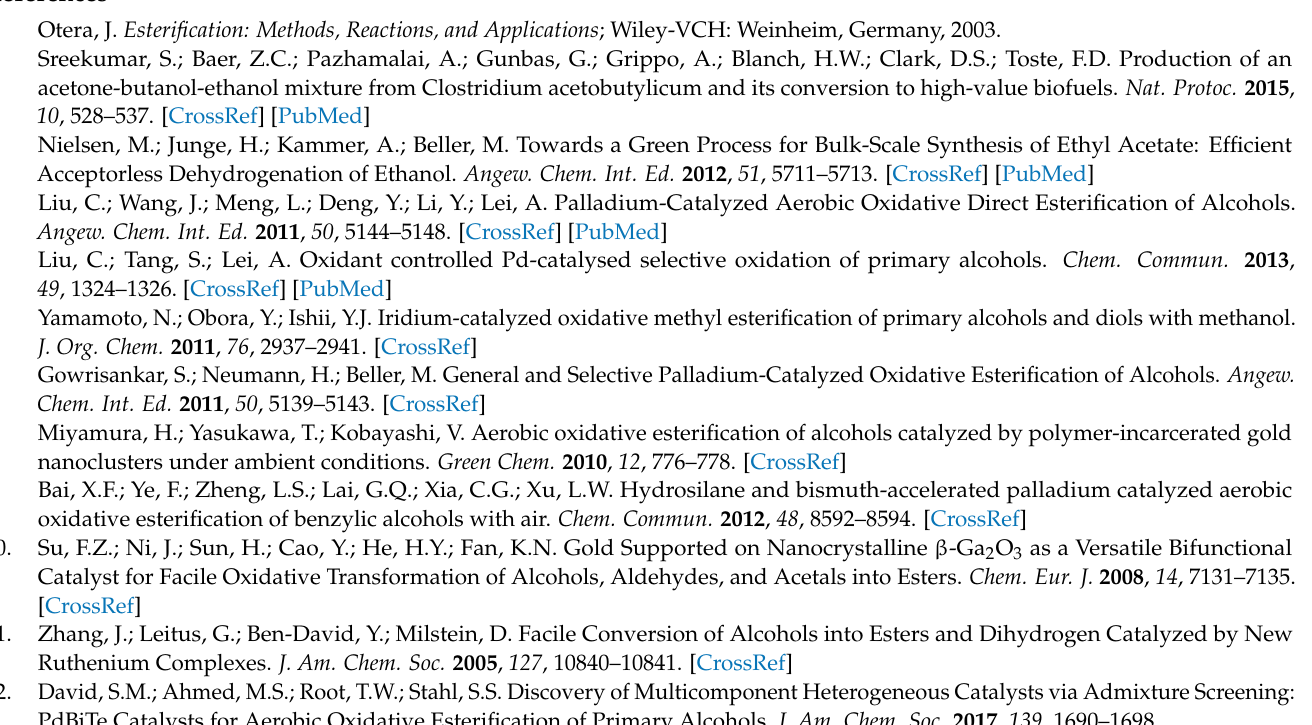
Supplementary Materials: The following are available online, Figure S1: XRD pattern of Co-N-Si/AC, Figure S2: EDX analysis of the Co-N-Si/AC catalyst, Figure S3: TEM images of Co-N/AC, Figure S4: Particle size distribution of Co-N-Si/AC, Figure S5: XPS spectra of N1s in Co-N-Si/AC, Table S1: Screening of optimal conditions for the synthesis of methyl benzoate, Table S2: Pore structure of the catalysts, Table S3: The binding energy and content of N in the catalyst, Table S4: Substrates employed for oxidative